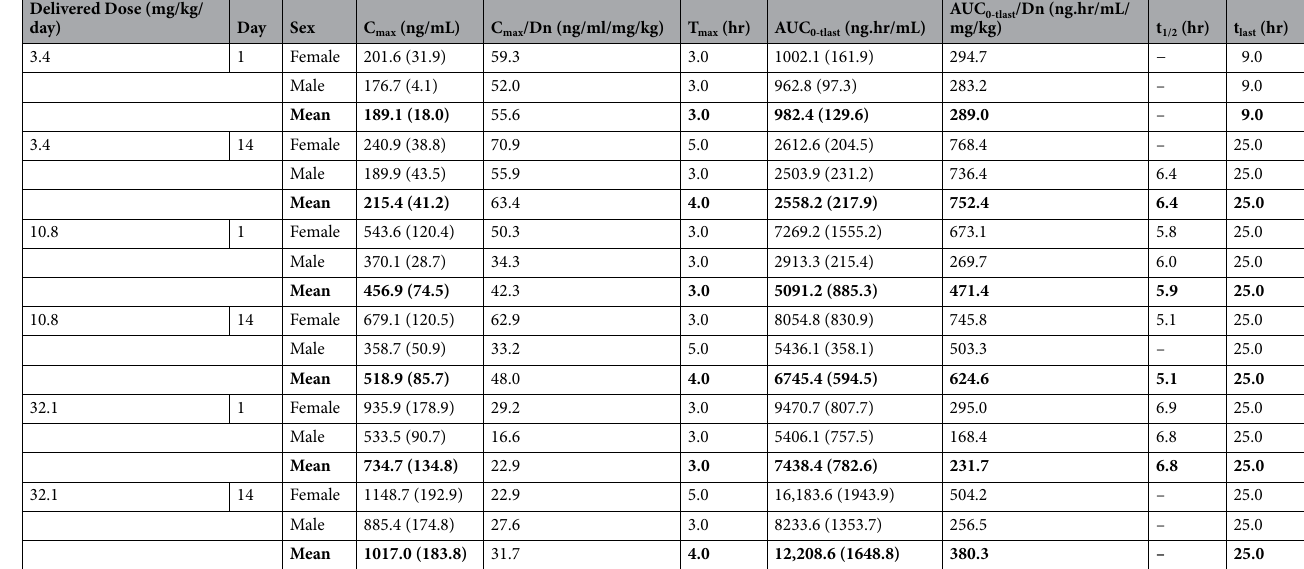
Table 3. Summary of Toxicokinetic Parameters (blood) for PCCR-1 in Sprague Dawley rats with inhalation administration. Mean values are in bold. *: T max and T last are calculated from the start of Inhalation dosing; delivered dose.